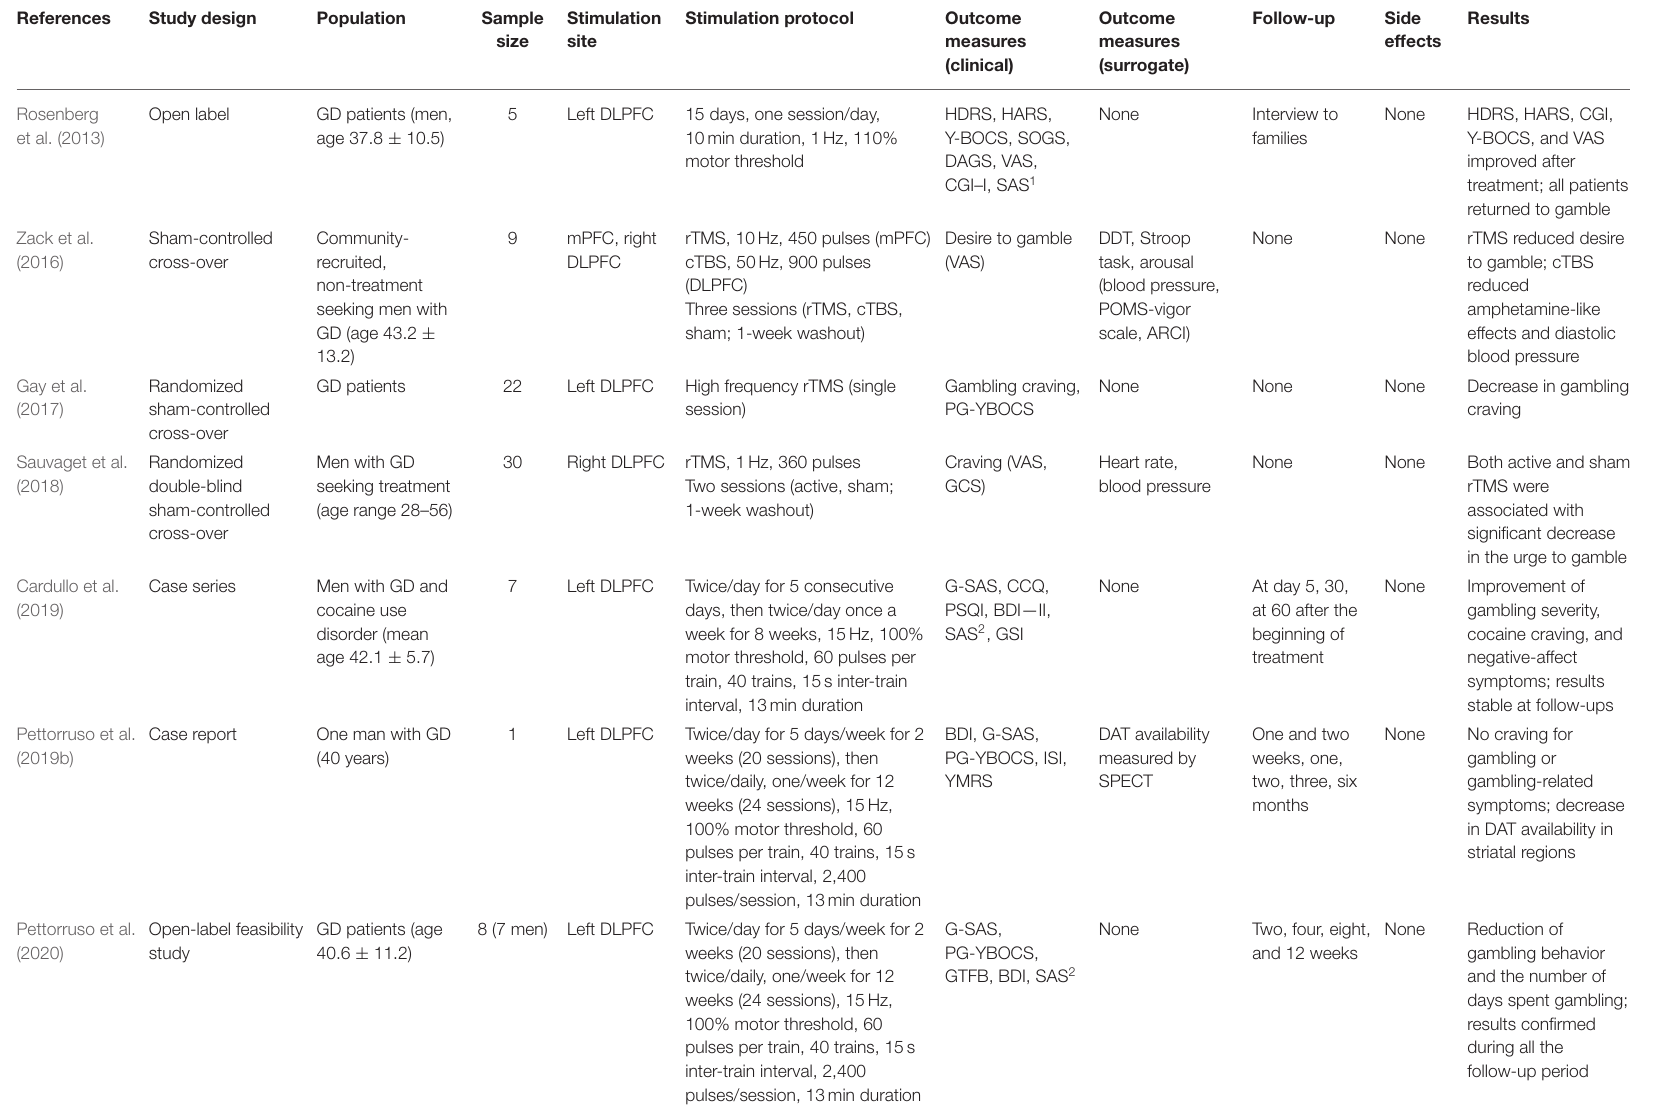
TABLE 1 | Overview of rTMS studies included in the